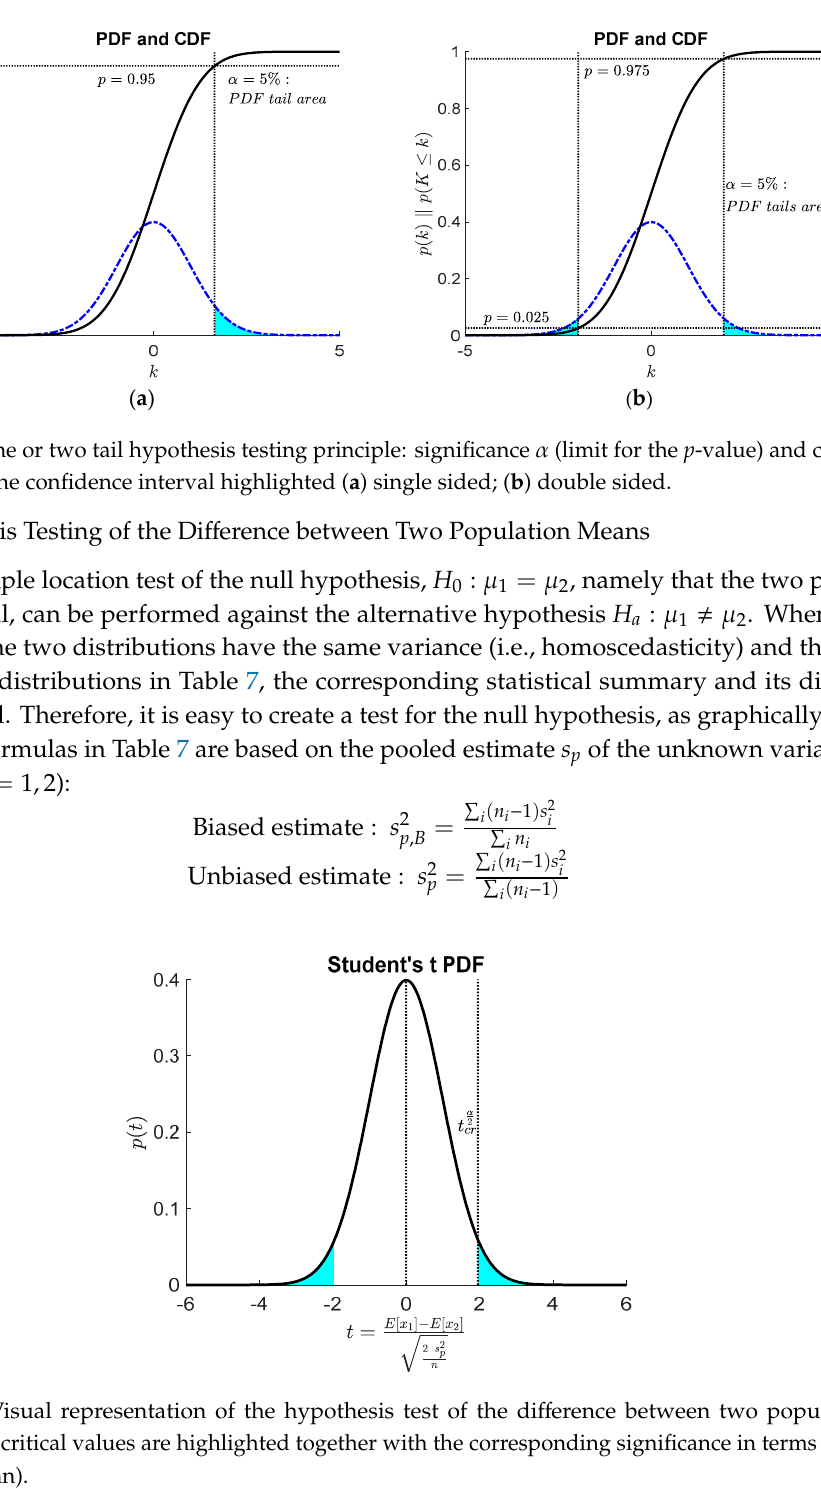
Figure 5. Visual representation of the hypothesis test of the difference between two population means—the critical values are highlighted together with the corresponding significance in terms of tail areas (in